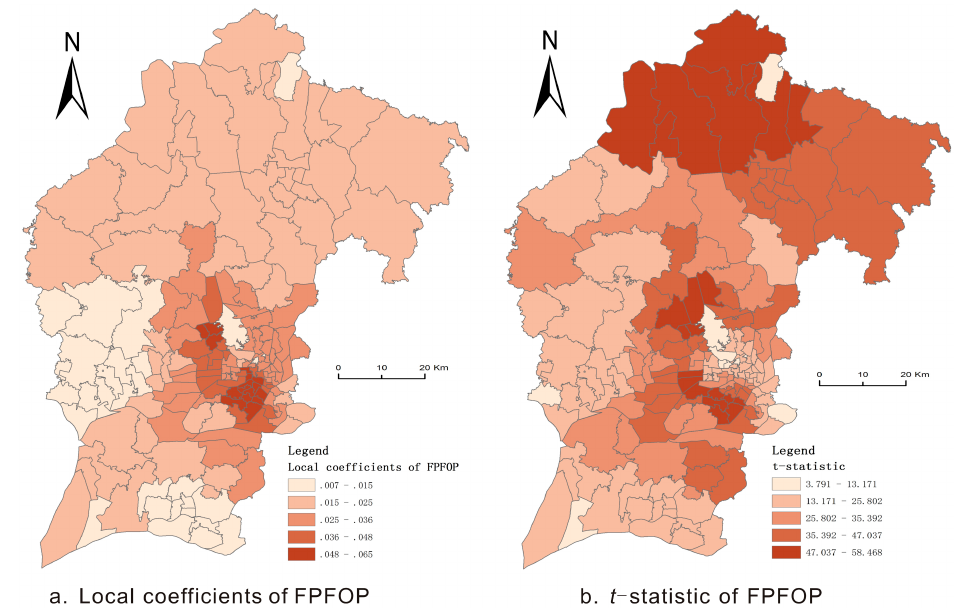
Figure 6. Distribution for local regression coefficients and t -statistics of FPFOP. Table 5. Results of geographical variability testing of local coefficients using Chi-Square test.